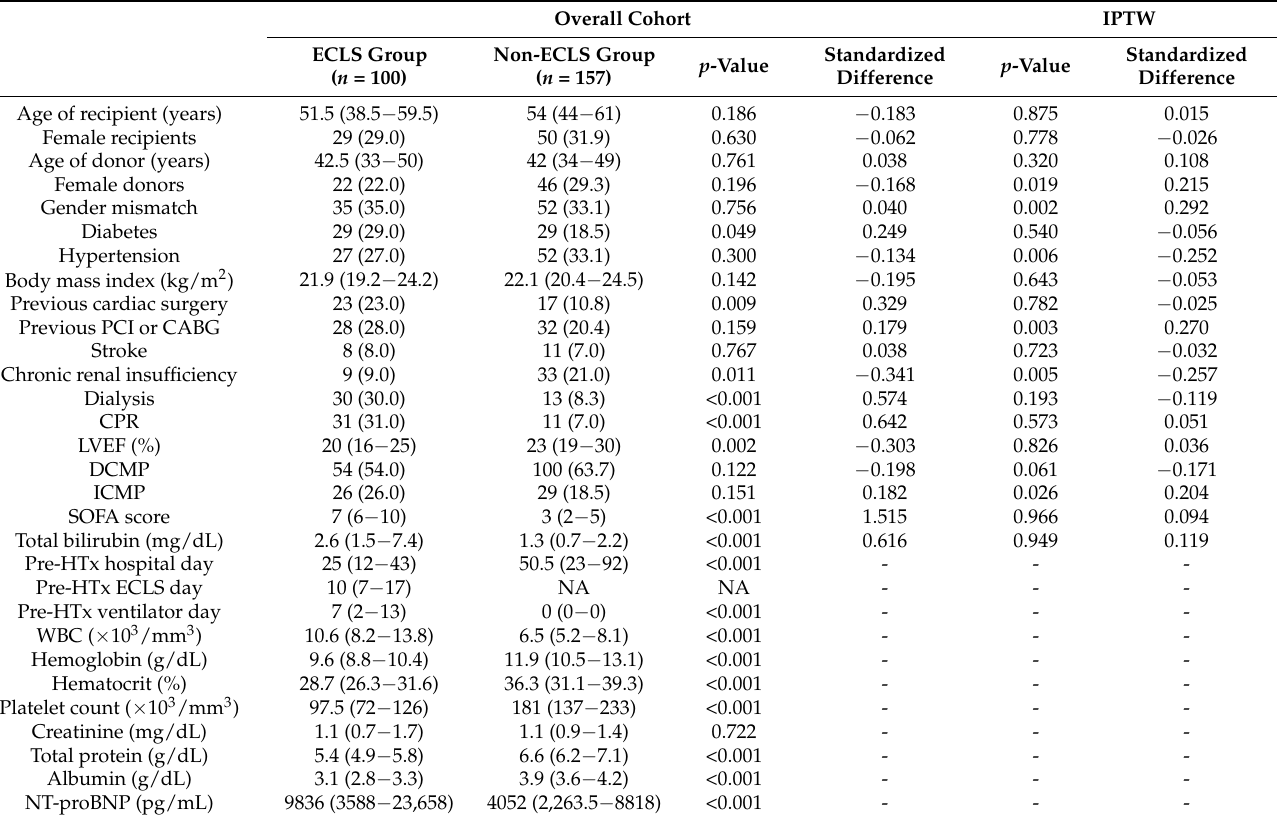
Non-normally distributed numerical variables are presented as medians (interquartile ranges) and were tested using the Wilcoxon rank-sum test. Categorical variables are presented as numbers (percentages) and were tested using the chi-square test or Fisher’s exact test. IPTW, inverse probability of treatment weighting; ECLS, extracorporeal life support; PCI, percutaneous coronary intervention; CABG, coronary artery bypass graft surgery; CPR, cardiopulmonary resuscitation; LVEF, left ventricular ejection fraction; DCMP, dilated cardiomyopathy; ICMP, ischemic cardiomyopathy; SOFA, Sequential Organ Failure Assessment; HTx, heart transplantation; NA, not applicable; WBC, white blood cell; NT-proBNP, N-terminal prohormone of brain natriuretic